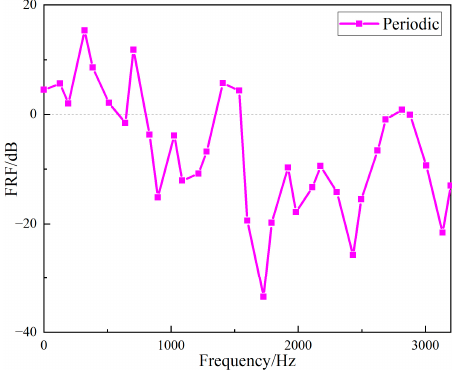
Figure 24. The Frequency domain FRF of the periodic structure support.